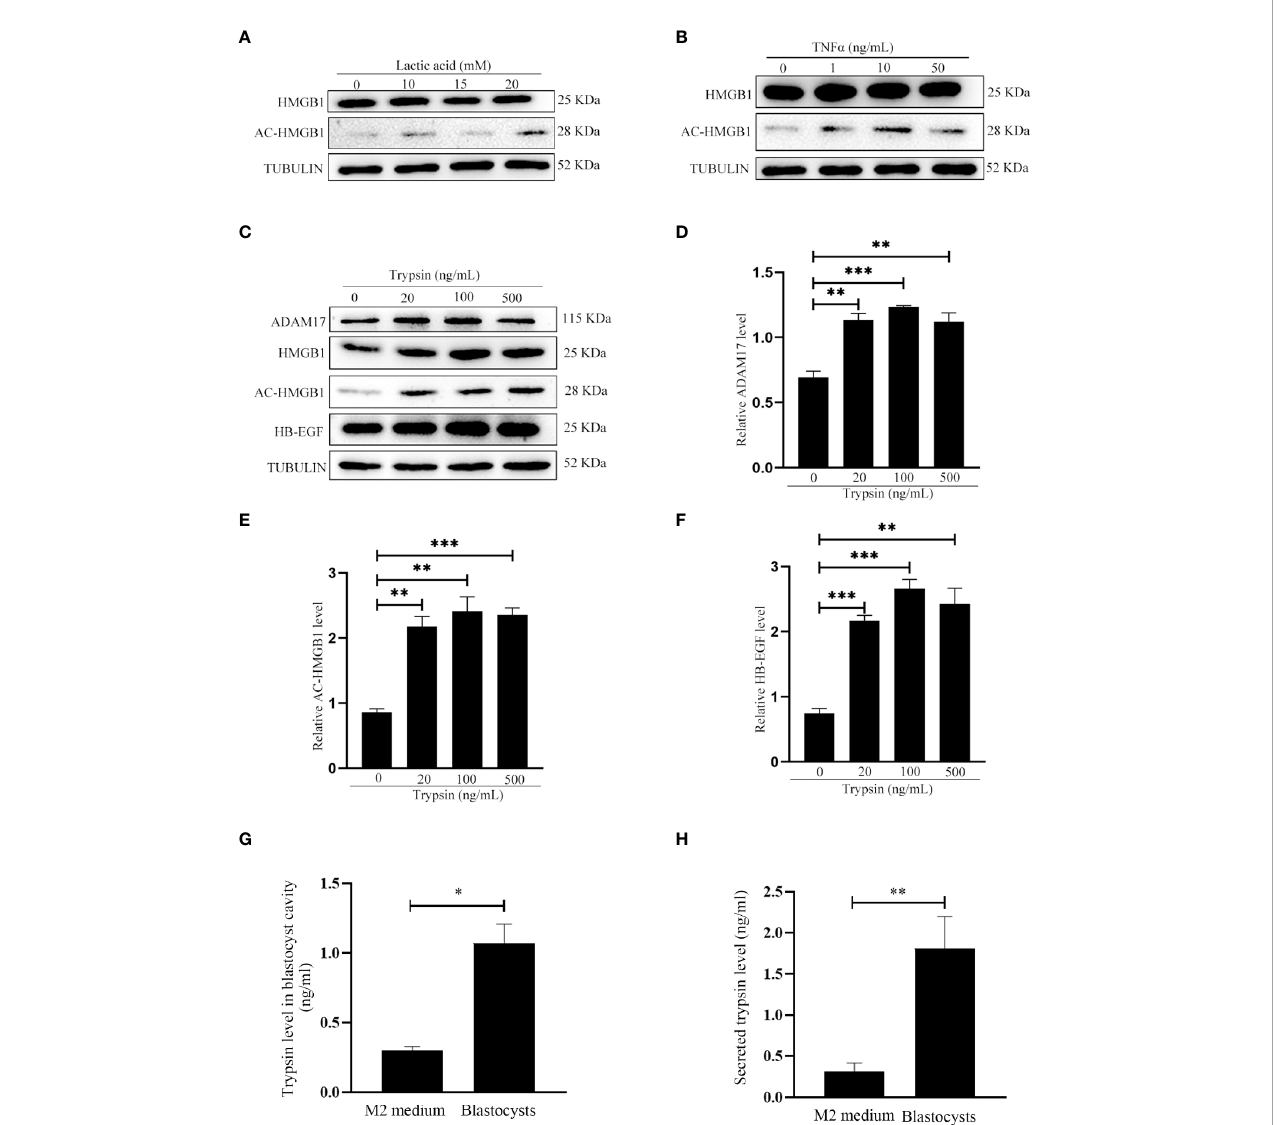
FIGURE 2 Effects of lactate, TNF a and trypsin on the levels of HMGB1, acetylated HMGB1, ADAM17 and HB-EGF in cultured mouse epithelial cells. (A) Western blot analysis of the protein levels of HMGB1 and acetylated HMGB1 after epithelial cells were treated with lactic acid for 15 min. (B) Western blot analysis of the protein levels of HMGB1 and acetylated HMGB1 after epithelial cells were treated with TNF a for 15min. (C) Western blot analysis of the protein levels of ADAM17, HMGB1, acetylated HMGB1 and HB-EGF after epithelial cells were treated with trypsin for 15 min. (D-F) Relative quantitative analysis on the protein levels of ADAM17, acetylated HMGB1 and HB-EGF in Figure 2E, respectively. (G) The trypsin level in blastocyst cavity from 100 mouse blastocysts. (H) The trypsin level in the supernatant after 100 mouse blastocysts were cultured in 200 m l of M2 medium for 6 h. **p < 0.01, ***p <